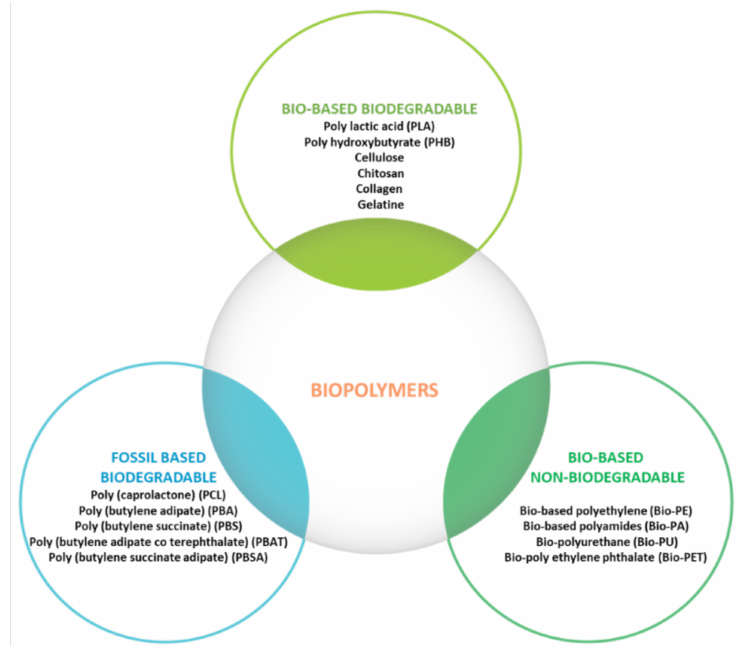
Figure 4. Biopolymer classification.